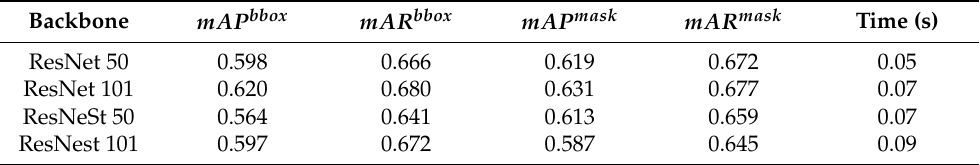
Figure 5. Scar identification with Mask RCNN using various backbones: ( a ) whole slide image with scar mask in yellow color and ( b ) magnified images of scar area, and ( c ) statistical comparison of measured scar areas (in pixel numbers) between conventional and machine learning methods. Blue and red boxes in ( a , b ) represent annotated answers (blue) and the predicted scar areas (yellow), respectively (scale bar = 3000 µm; ( c ) C = conventional method; AS = annotated scar; R50 = ResNet 50; R101 = ResNet 101; Rs50 = ResNeSt 50; Rs101 = ResNeSt 101; * p < 0.05 C vs. R101). Table 2. Detection and segmentation results of scar by using Mask region-based convolutional neural network (R-CNN) with feature proposal network (FPN) and various backbones (ResNet50, ResNet10, ResNeSt50, and ResNeSt101): mean average precision (mAP) and mean average recall (mAR). Backbone